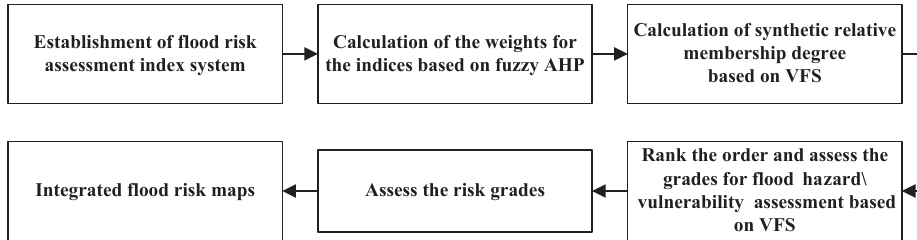
Fig. 9. Flow chart of flood disaster risk assessment.